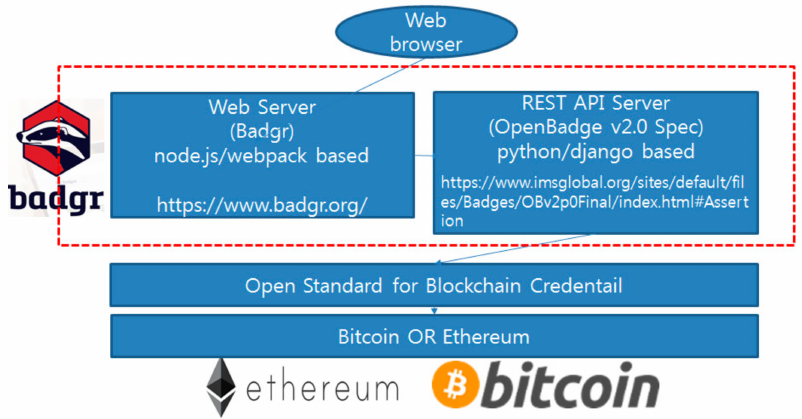
Figure 10. System components and interfaces for blockchain based digital badge